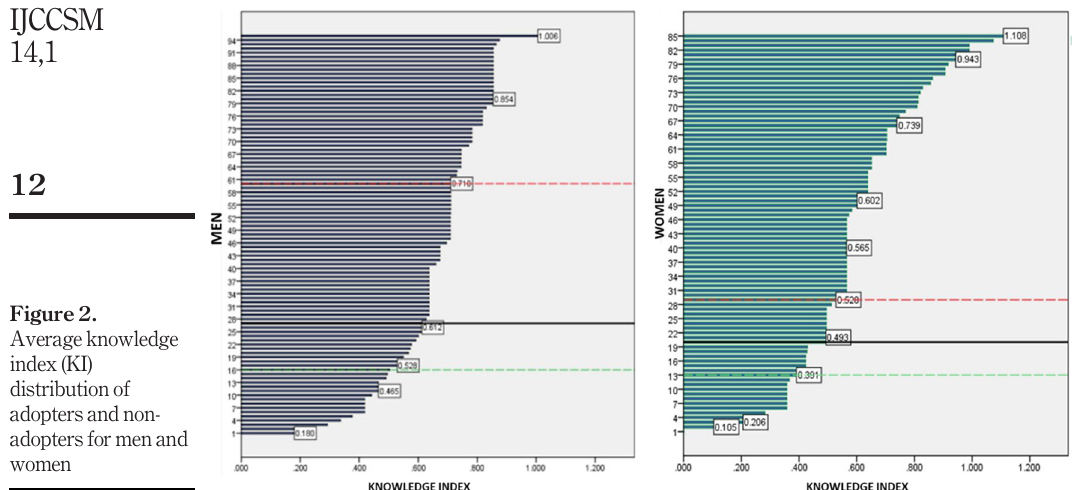
Figure 2. Average